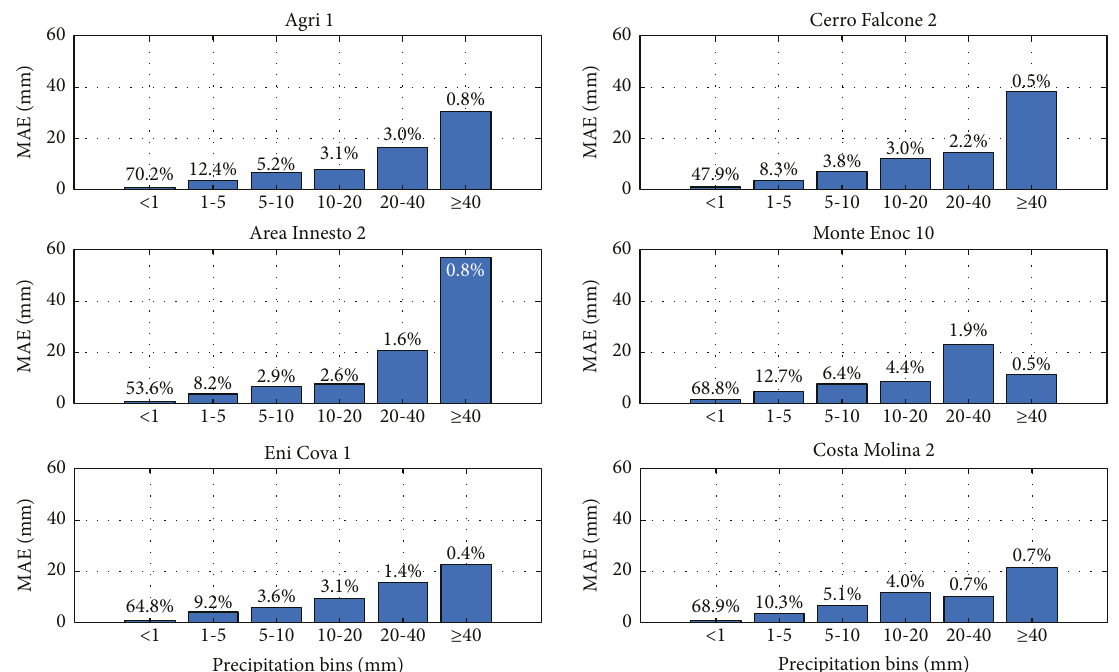
Figure 11: Mean absolute errors for precipitation thresholds in the two years of the observation period over the six weather stations at day +1 as lead time for the KALM-HD model with 5km. Values in red are referred to as the percentage of analyzed events in each